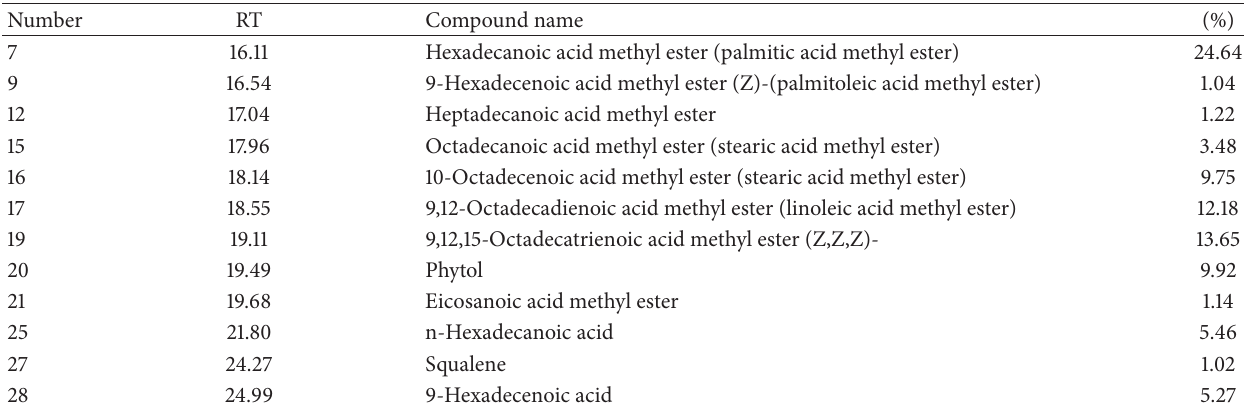
Table 3: Antimicrobial compounds, retention times, and percentages of methanol leaf extract of Andrographis paniculata analyzed by a gas chromatography mass spectrometry.